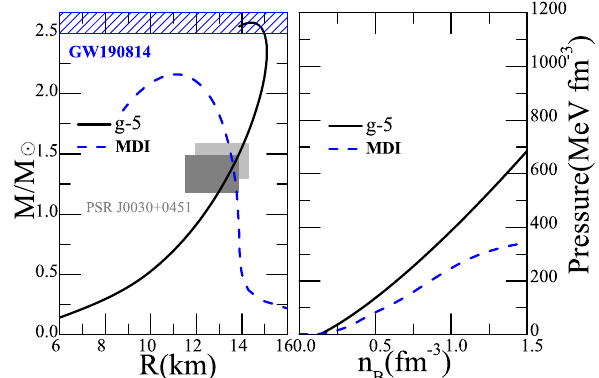
Fig. 6 Left panel: Mass-radius relation for quark stars and neutron stars. Right panel: The pressure of quark star matter and neutron star matter as functions of baryon density